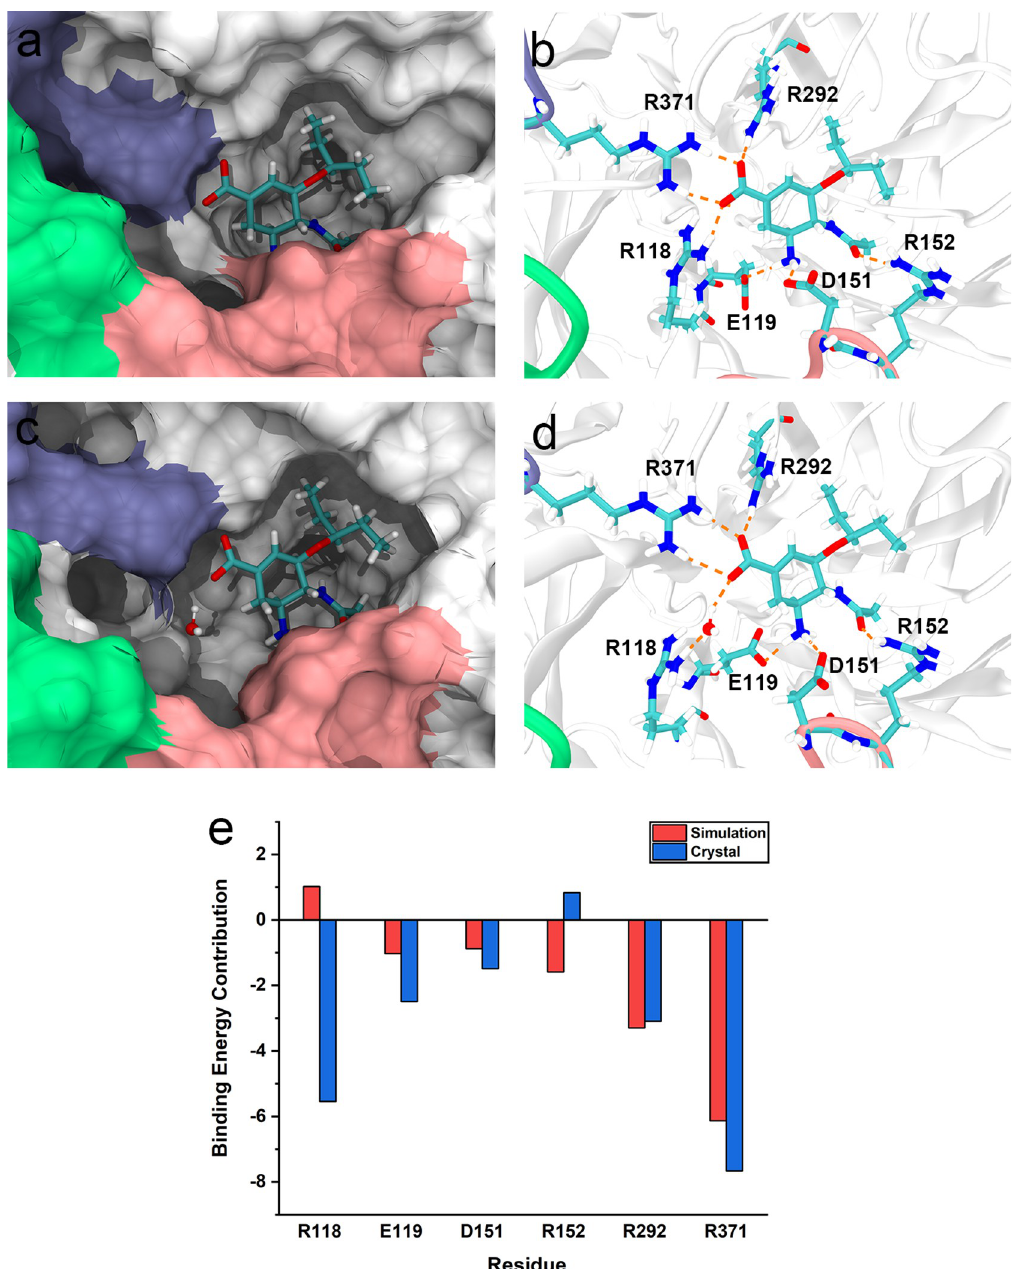
Fig 7. Comparison of the oseltamivir-NA interactions in the crystal structure and simulation. The H-bond is represented as an orange dotted line. (a and b) Oseltamivir-NA interaction in the crystal structure (PDB ID: 2QWK) in which oseltamivir forms a direct H-bond with R118. (c and d) Oseltamivir-NA interactions in the simulation (S9) in which oseltamivir forms a water-mediated H-bond with R118. (e) Per-residue decomposition energies for selected amino acids in the crystal structure and